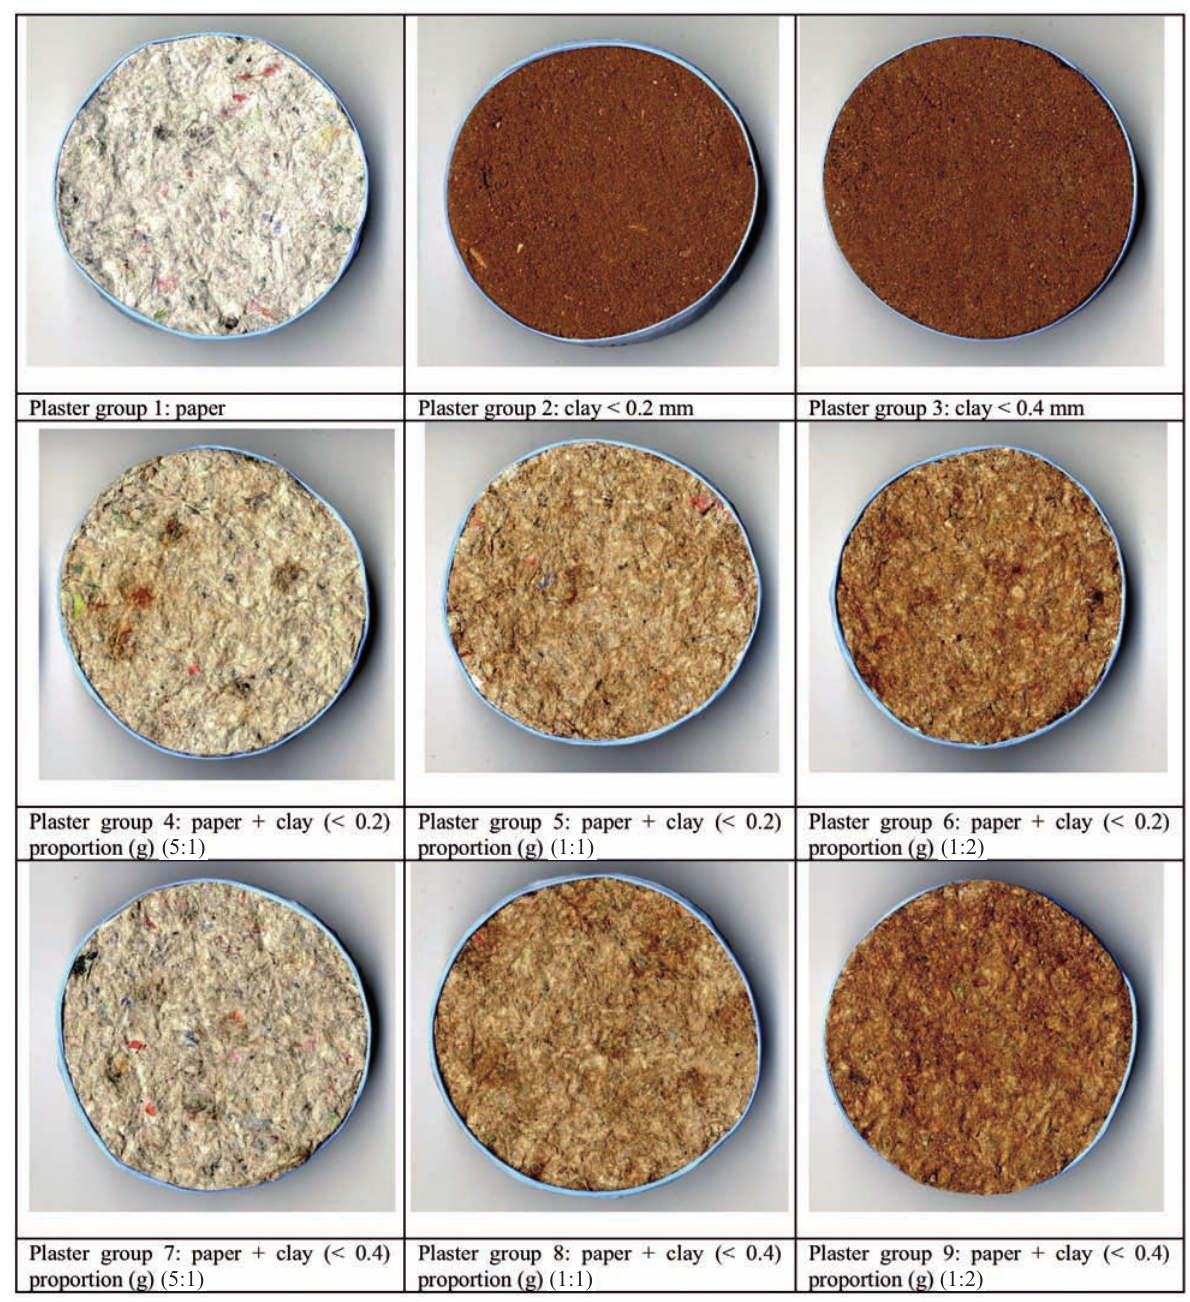
Fig. 1. Examples of specimen